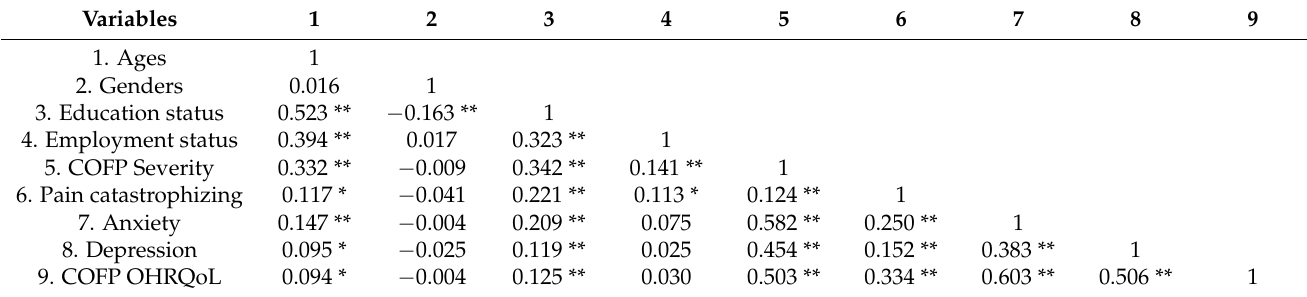
Table 2. Pearson analysis between sociodemographic characteristics and COFP severity, pain catas- trophizing, anxiety, depression, and OHRQoL.